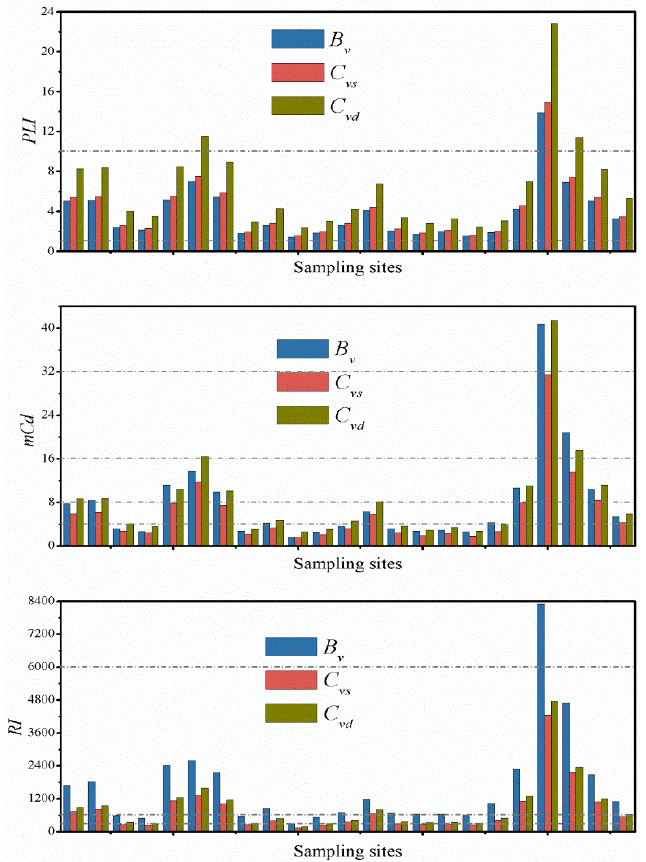
Figure 4. The distribution of the PLI, mCd, RI values for Cr, Ni, Cu, Zn, As, Cd, Tl, Pb, and Hg in sediments in the whole investigated region based on different types of background values.